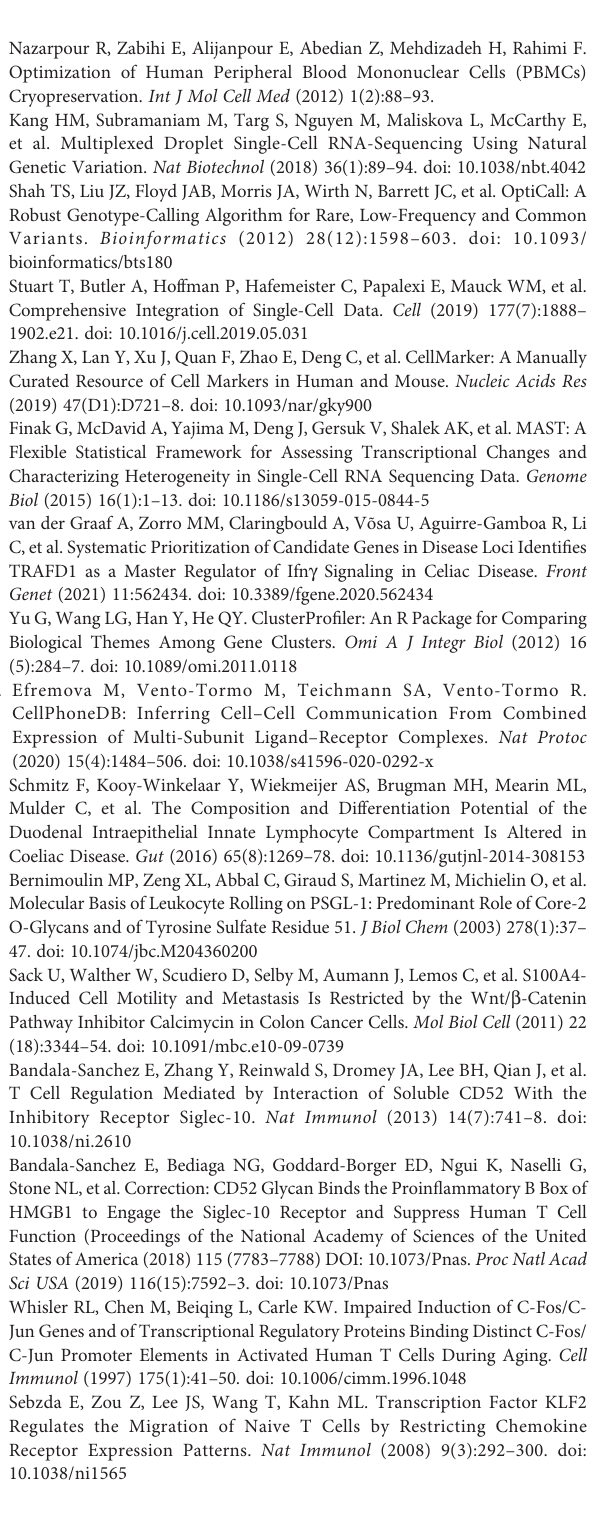
Supplementary Table 4 | Enriched pathways of active CeD genes in CD4+ T cells. Supplementary Table 5 | Enriched pathways of pre-diagnostic CeD genes in CD4+ T cells.